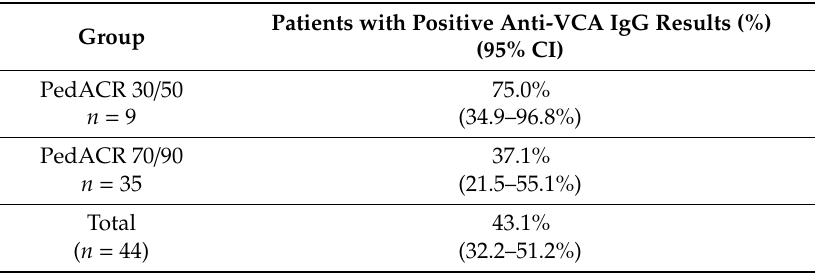
Table9. Prevalenceofpositiveanti-VCAIgG( > 1.1U / mL)resultsaftersixmonthsoftreatmentinpatients with a poor (PedACR 30 / 50) and good (PedACR 70 / 90) response to treatment; CI—confidence